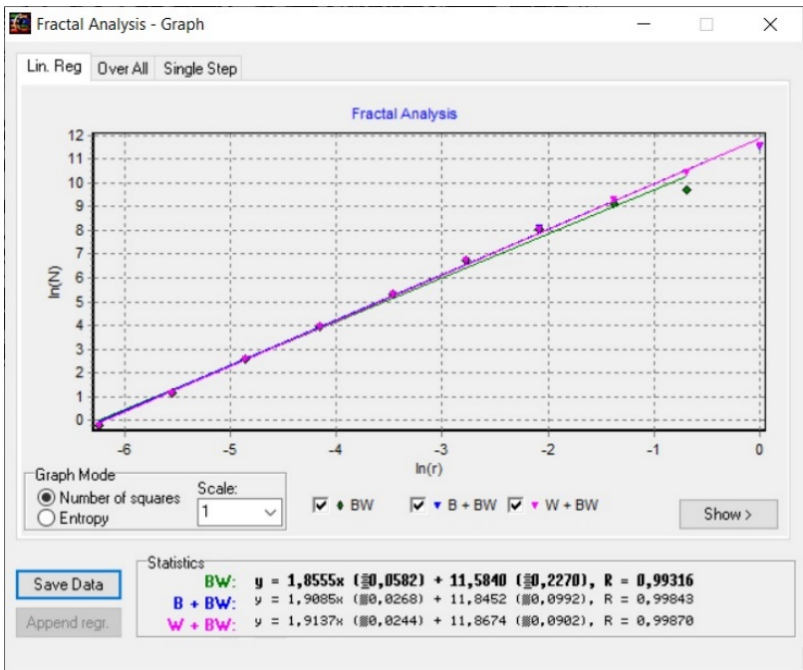
Figure 9. Graphic of fractal dimension for elected P 1 picture zone.